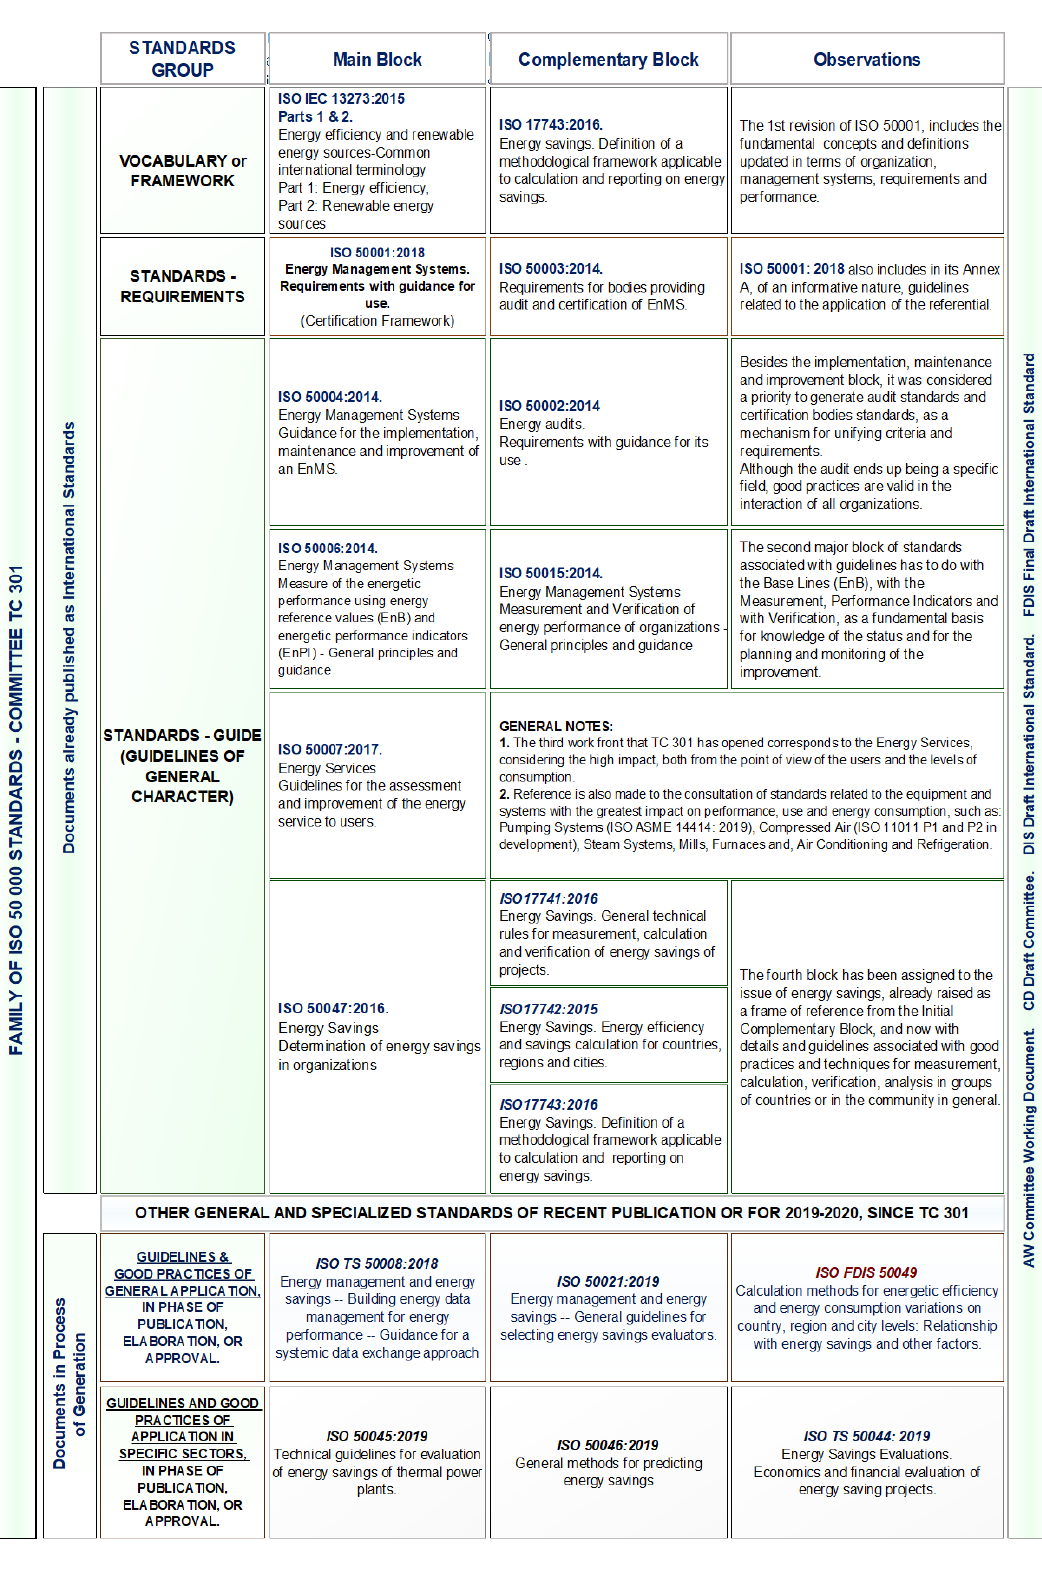
Figure A5. Approach and Logical Structure of the ISO 50000 Family of Standards [28,52 – 55,99].